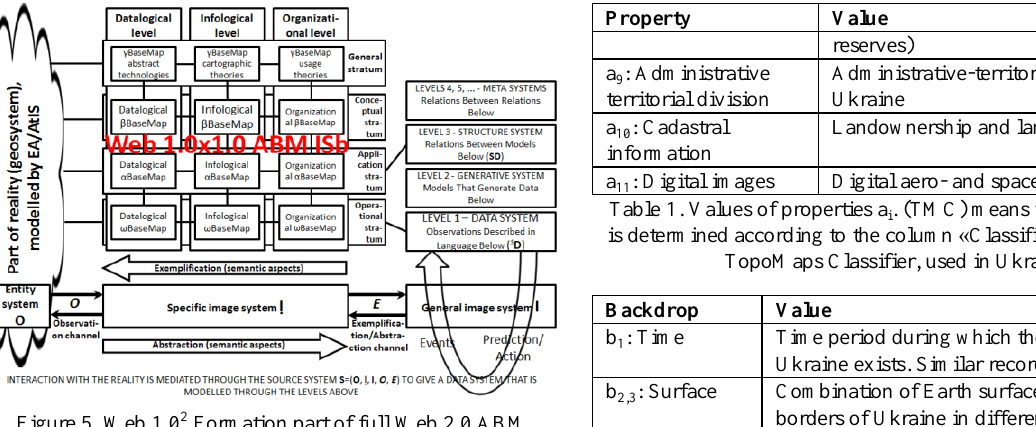
Figure 5. Web 1.0 2 Formation part of full Web 2.0 ABM